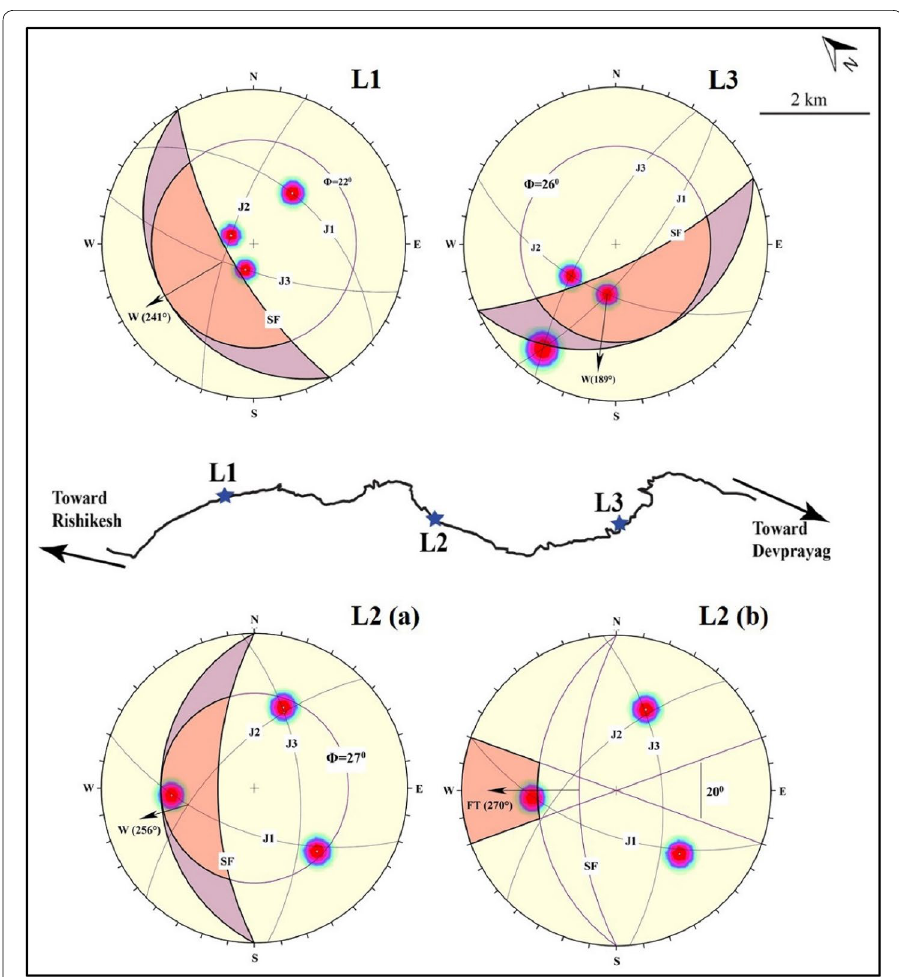
Fig. 3 Kinematic analysis of studied locations, indicating failure type and direction (shaded area shows possible failure envelope)